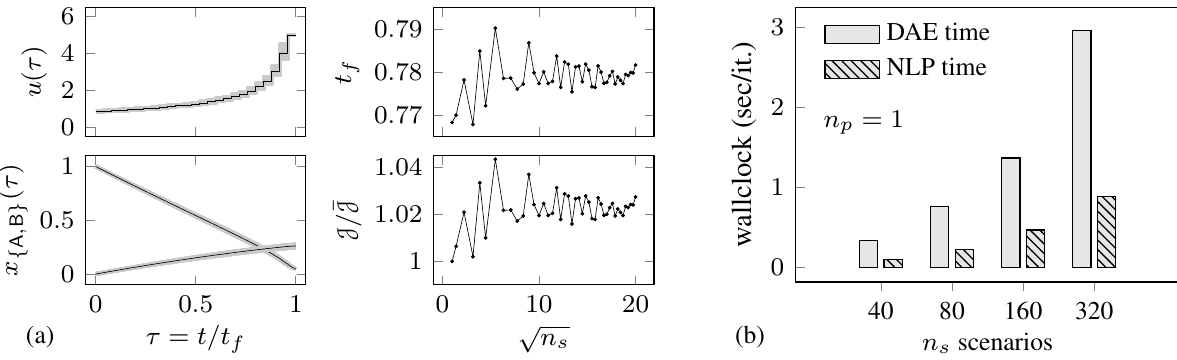
Figure 2. Case Study 1: ( a ) control input and state trajectories (nominal solution represented by the solid line) and ( b ) base line DAE and NLP solution times for increasing n